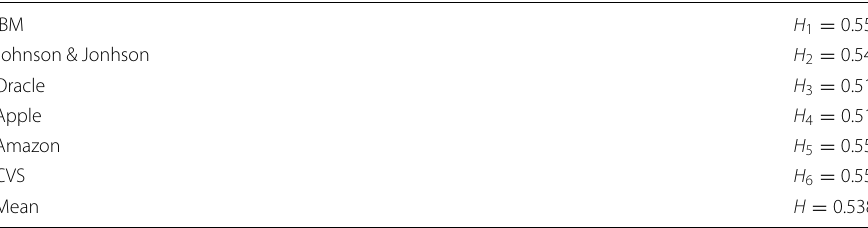
Table 2 Estimated hurst Index H n